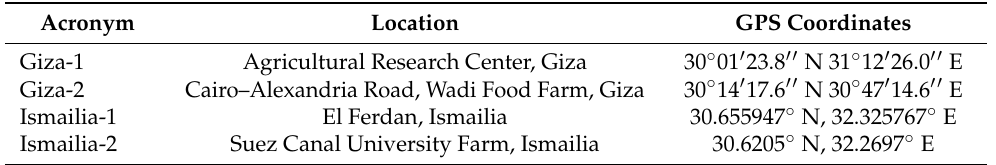
Figure 1. S ampling locations: (1) Giza, (2) Ismailia. Figure 1. Sampling locations: (1) Giza, (2) Ismailia. Table 1. Sampling Table 1. Sampling locations.